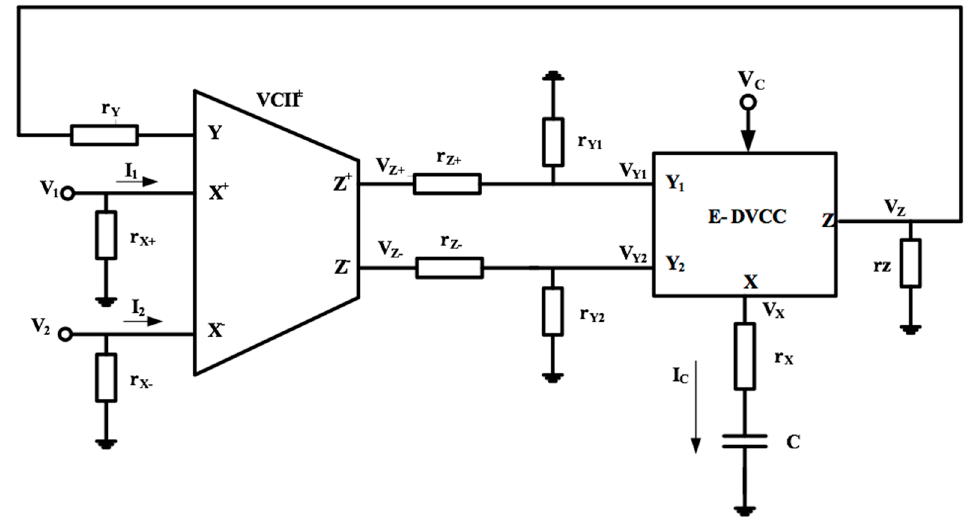
Figure 4. Proposed positive floating capacitor simulator with parasitic